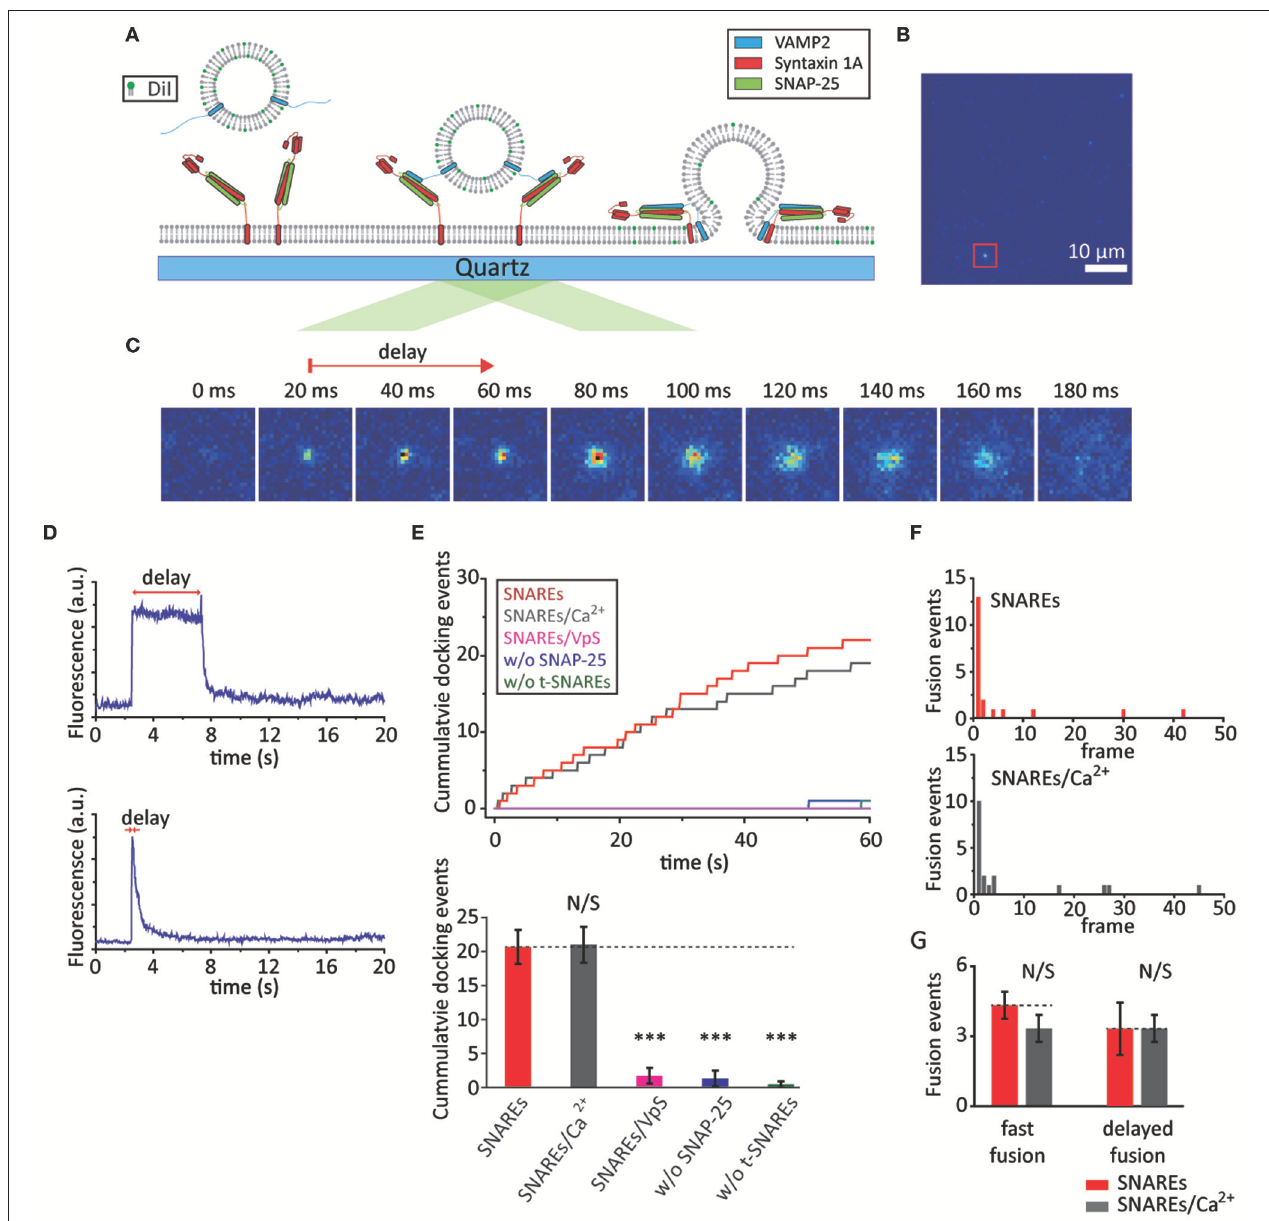
FIGURE 1 | SNAREs are capable of mediating fast membrane fusion. (A) Schematics for the single vesicle-to-SBL fusion assay. (B) Screen shot (55 × 55 µ m) of the video recording. The red box indicates a docked vesicle. (C) Time lapse of a single membrane fusion event; each image is 20ms apart. The red arrow indicates the time delay between docking and the start of fusion. The time delay here is 40ms. (D) Time traces of slow (upper) and fast (below) membrane fusion events are shown. (E) Docking events with SNAREs only (red) and SNAREs with 500 µ M Ca 2 + (gray). The controls with t-SBL deactivated by VpS (magenta), with t-SBLs constructed without SNAP-25 (blue), and without both SNAP-25 and syntaxin 1A (green) are also shown. Representative traces of cumulative counts of docking against time (upper) and the number of docked vesicles during the 1min observation period. We observed a total of 62, 63, 5, 4, and 1 docking events for SNAREs, SNAREs/Ca 2 + , SNAREs/VpS, w/o SNAP-25, and w/o t-SNAREs, respectively. (F) A representative histogram of docking-to-fusion delay distribution with only SNAREs in the absence (upper) and presence of Ca 2 + (below). We observed a total of 23 and 20 number of fusion events in the absence and presence of Ca 2 + from three independent video recordings, respectively. Each frame is 20ms apart. (G) The number of fusion events occurring within the 1 st frame (fast fusion) and the sum of those occurring thereafter (delayed fusion) within a 1min recording. For (E) and (G) the data are shown as means ± SD . Statistical significance was assessed by Student’s t -test (*** p < 0.005; NS, no significant difference; n = 3 independent experiments). the flow chamber we do not observe any apparent changes in docking kinetics when compared with the results without Ca 2 + ( Figure 1E